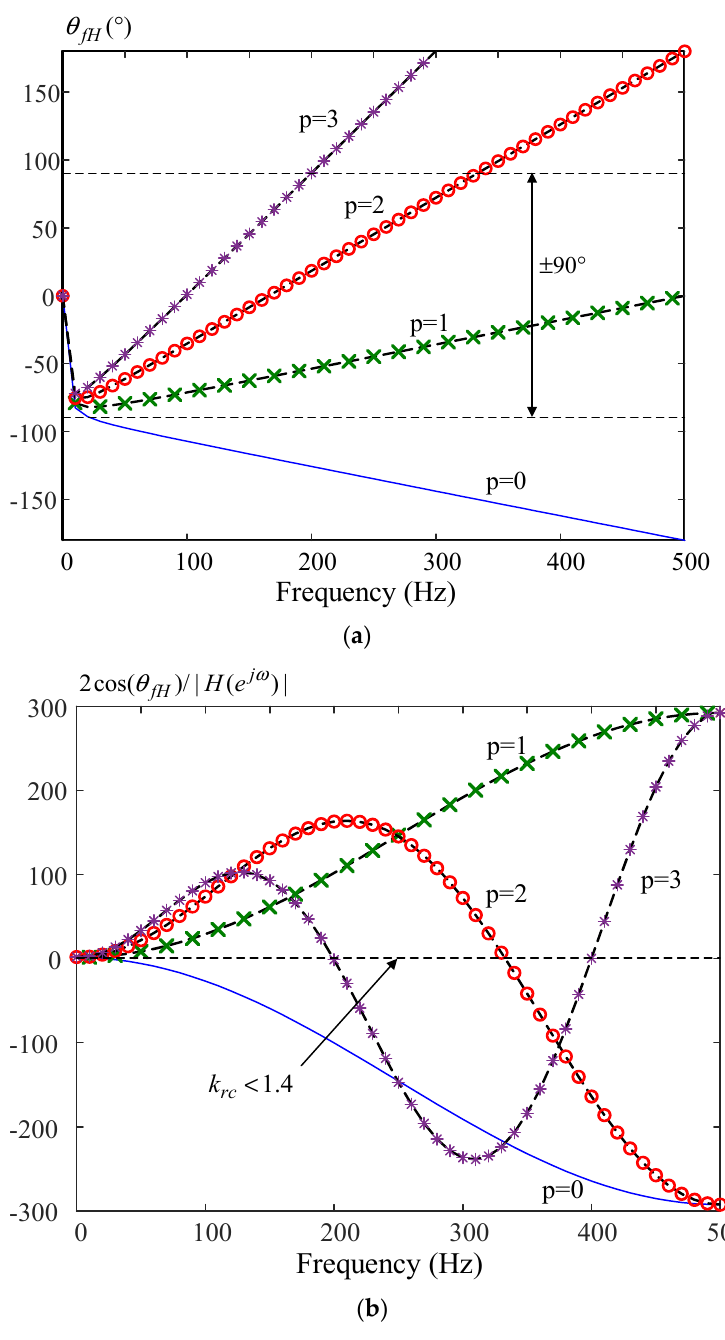
Figure 4. The boundary of control parameters: ( a ) phase lead; ( b ) gain.